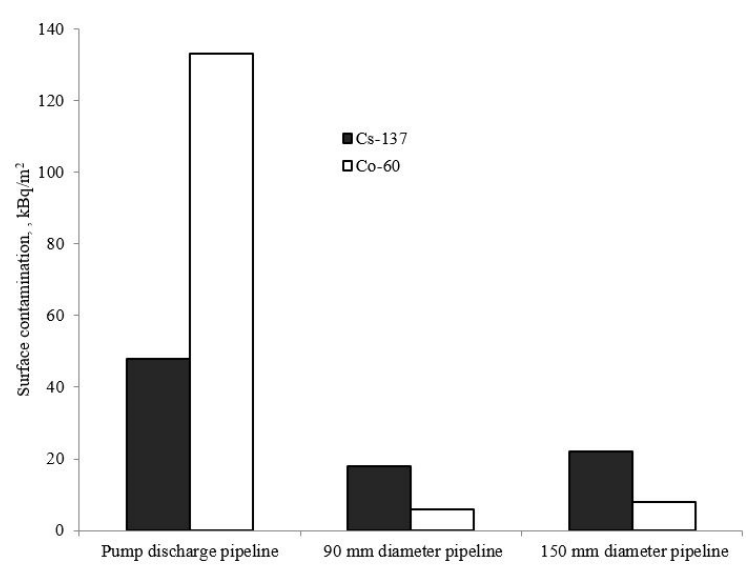
Figure 3. Weakly fixed radioactive contamination on the surface of the pipelines in the test circuit.